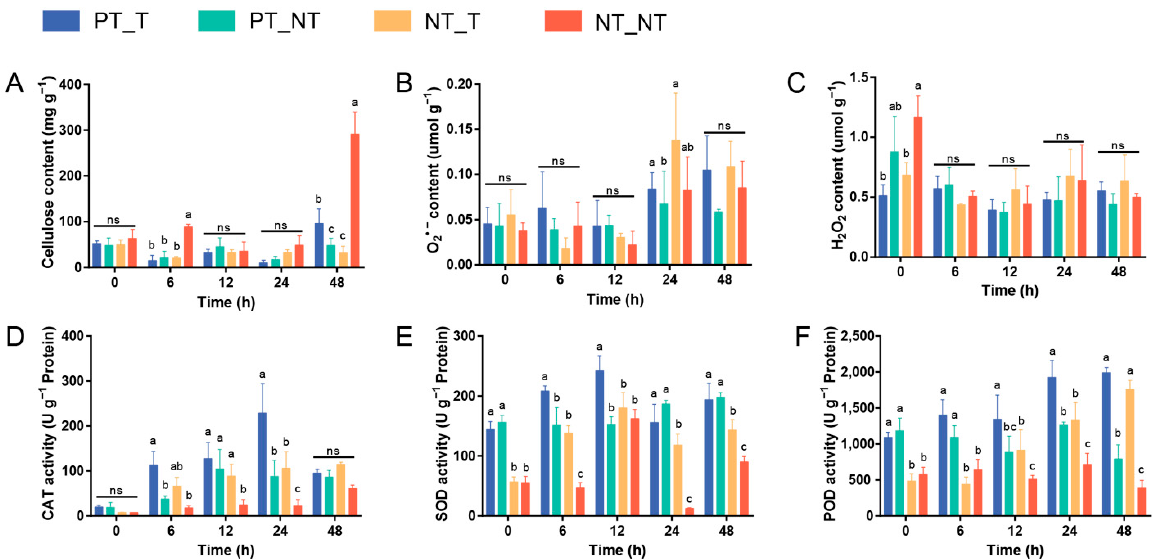
Figure 2. Biochemical analyses of cell wall integrity and antioxidation capacity of SPSC to YE stress. The levels of cellulose ( A ), O 2• − ( B ) and H 2 O 2 ( C ), and the activities of CAT ( D ), SOD ( E ), and POD ( F ) in SPSCs. Different lowercase letters above columns indicate statistical differences at p < 0.05 by one-way ANOVA ( n = 3). ns, not significant.